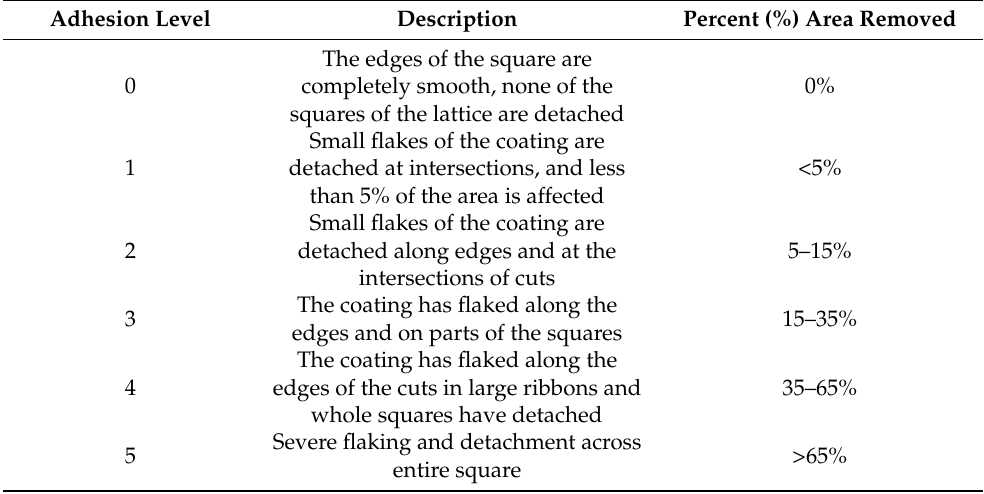
Table 1. Adhesion level of cross-cut